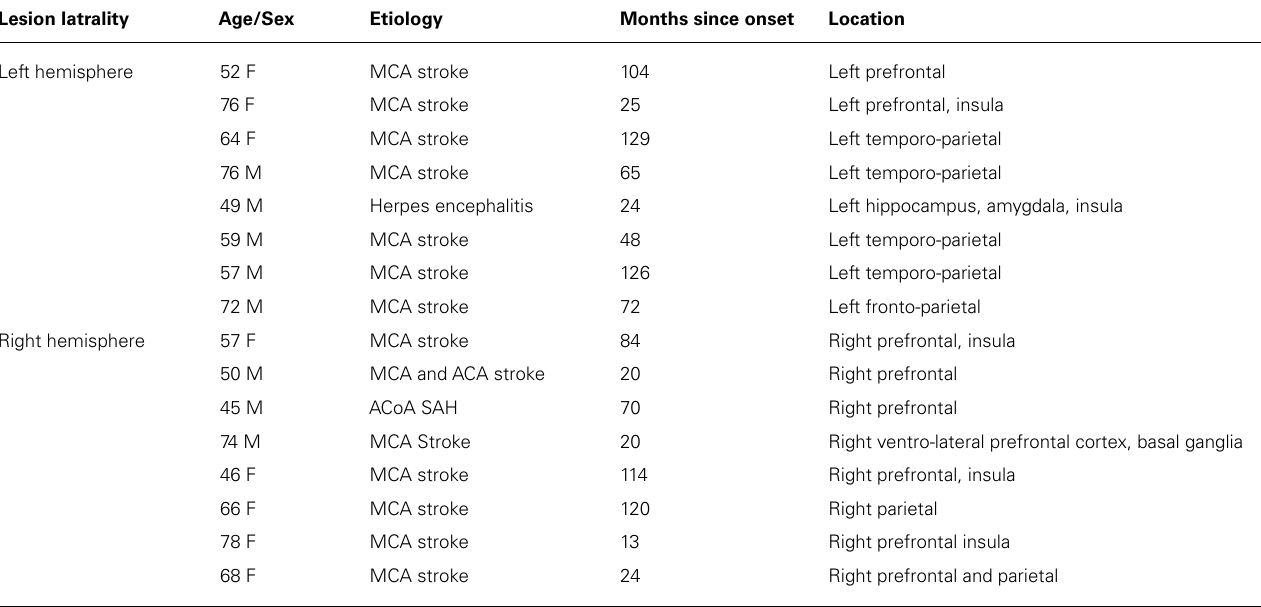
Table 1 | Clinical details of left hemisphere and right hemisphere groups. Lesion latrality Age/Sex Etiology Months since onset